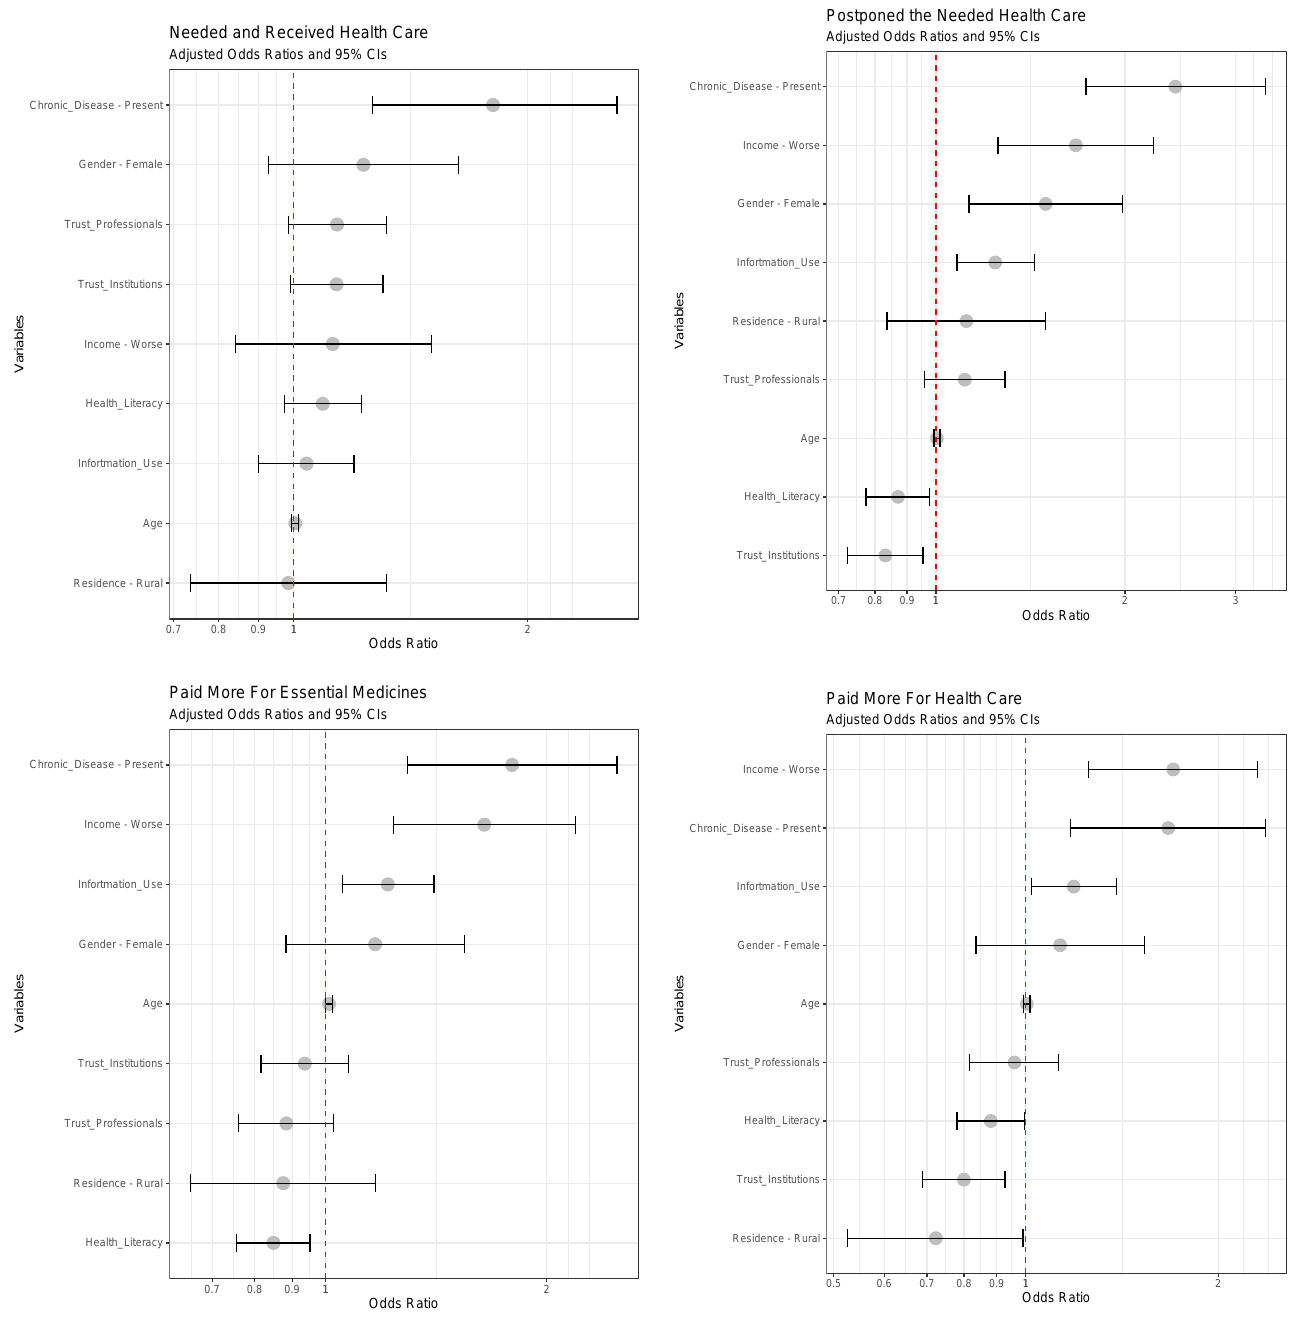
Figure 2. Associations between selected endpoints of barriers of access to care, postponements of care, and increased expenses for medicines and health care with relevant predictors; logistic regression adjusted odds ratios with 95% confidence intervals.